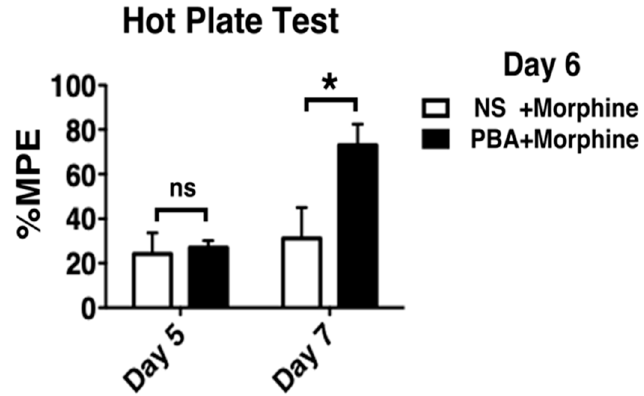
Figure 4. The pharmacological ER chaperone PBA restored morphine analgesia. Morphine (20 mg / kg) was administered intraperitoneally twice a day for 5 consecutive days. On day 6, intraperitoneal morphine (20 mg / kg) and oral normal saline (NS) was then administered twice in in the NS + Morphine ( n = 5) group, while intraperitoneal morphine and oral PBA (1 g / kg) was administered twice in the PBA + Morphine ( n = 5) group on day 6. Hot plate testing was performed after the tenth drug administration on day 5 and after intraperitoneal morphine injection on day 7. %MPE is described in Materials and Methods. By definition, the single longest response latency can occur in any time points. * p < 0.05, two-way analysis of variance with Bonferroni post-hoc test. ns, not significantly different.